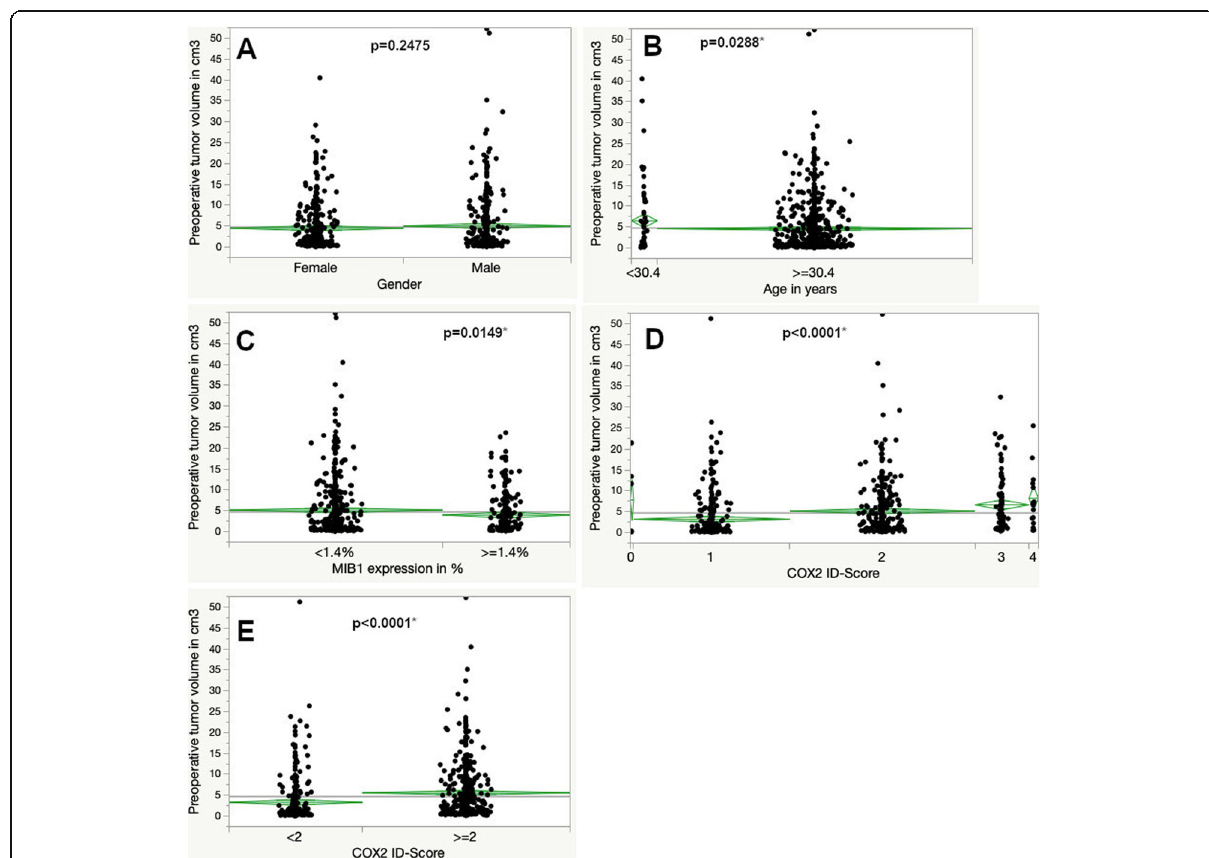
Fig. 2 Tumor growth in percent increase of volume per year according to gender ( a ), age ( b ), MIB1 ( c ) and COX2 expression ( d and e ) (ANOVA, asterisk represents statistically significant results)